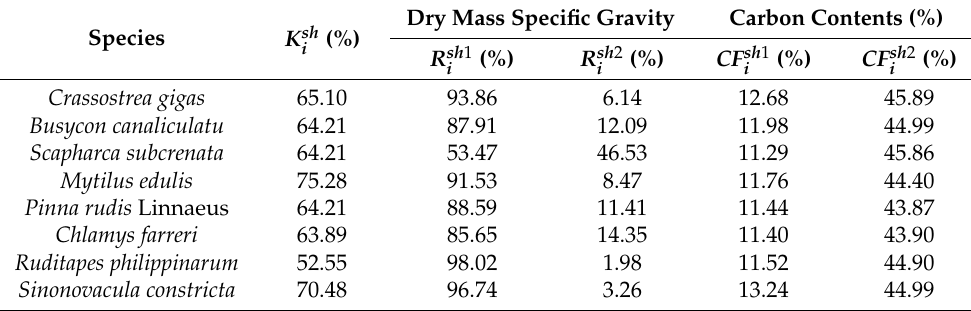
Table 1. Assessment parameters of shellfish carbon sink